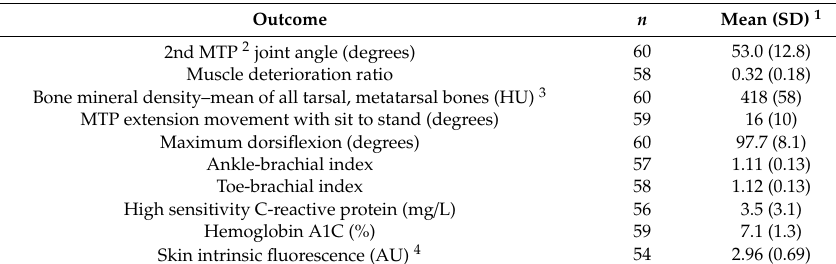
Table 2. Descriptive statistics for primary and secondary